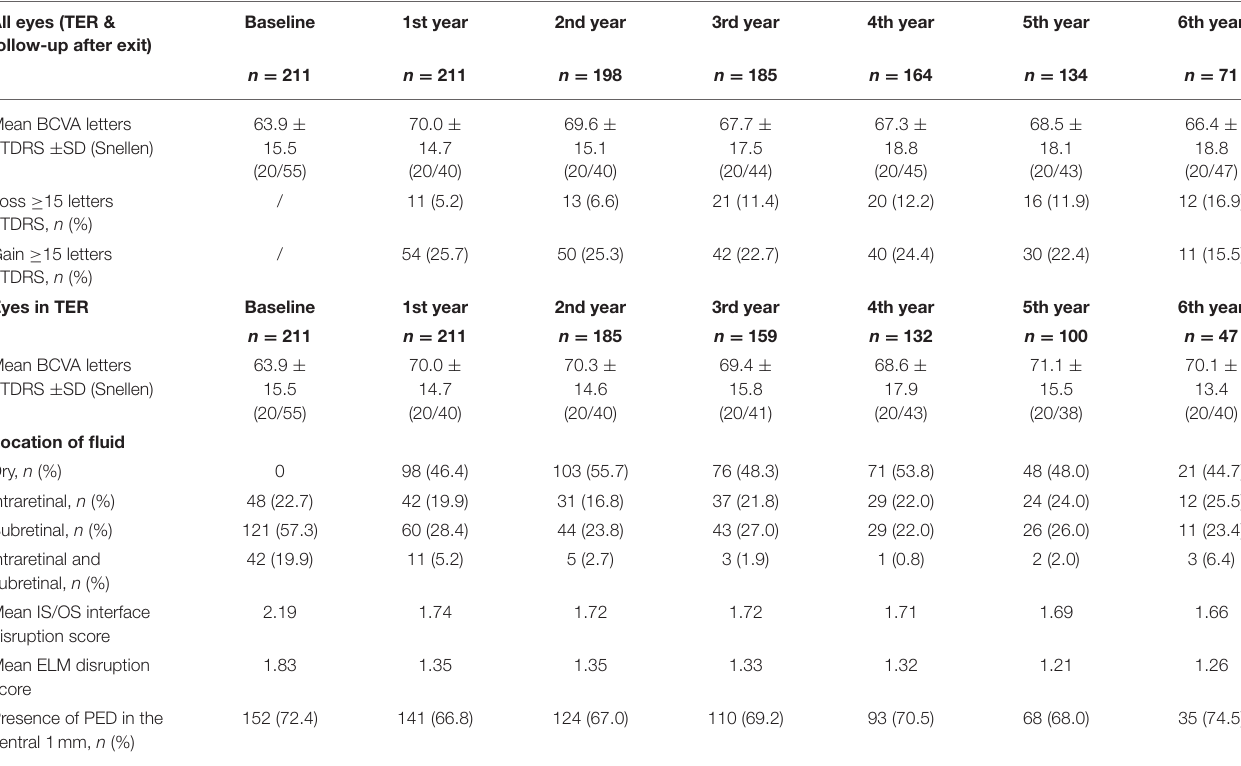
TABLE 3 | Change in functional and morphological outcomes during